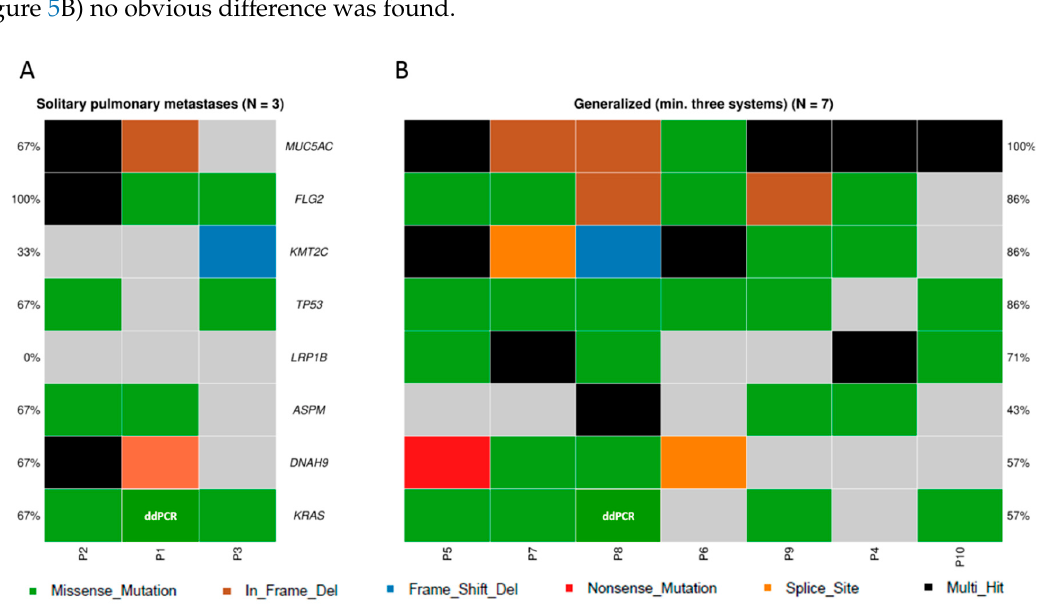
Figure 5. Oncoplot of genes with highest counts of variants in primary tumors. Comparison between groups of ( A ) patients with solitary pulmonary metastases and ( B ) patients with generalized disease. Top five mutated genes in both groups are shown. Genes in the FLAGS list (Supplementary Table S3) were not used for the analysis. The ddPCR results are included and highlighted in white letters.